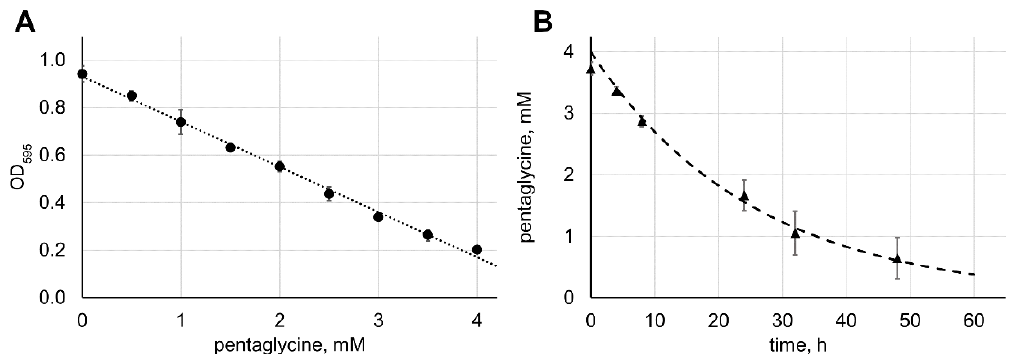
Figure 3. Derivation of lysostaphin catalytic parameters. ( A ) Di-, tri-, and pentaglycine were mixed, aliquoted, frozen, thawed, and treated with ninhydrin identically to lysostaphin-treated samples. To simulate the process of pentaglycine hydrolysis, we chose the concentrations of di- and triglycine so that at 4 mM pentaglycine, no di- or triglycine were added; at 3 mM pentaglycine, 1 mM each of di- and triglycine were added; etc. At 0 mM pentaglycine, the mixture contained 4 mM each of di- and triglycine. The average results from three independent experiments are shown; error bars represent standard deviation. ( B ) The calibration curve from panel A was used to convert the optical density values of the reaction of 4 mM pentaglycine with 5 µM lysostaphin (Figure 1A) into the pentaglycine concentrations and fitted with the simplified Michaelis–Menten equation (dashed line).